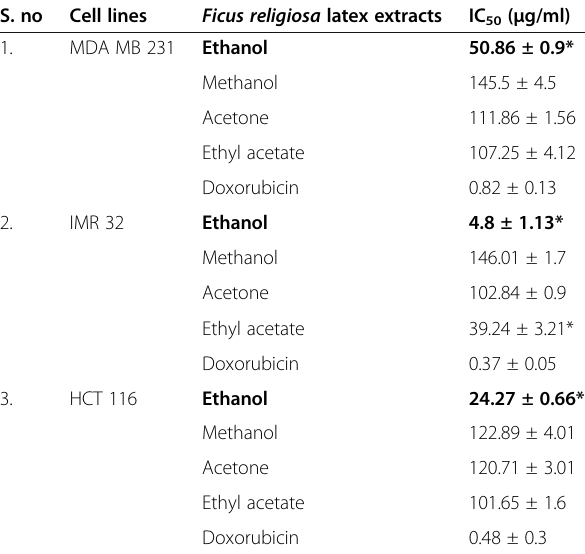
Table 3 IC 50 ( μ g/ml) values of F. religiosa latex extracts on human cancer cell lines exhibiting best activity